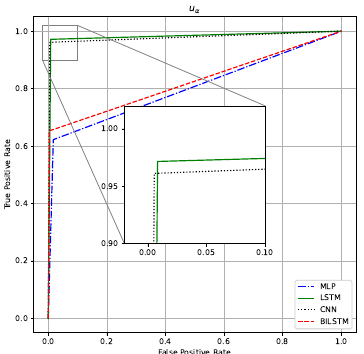
Figure 14. ROC curve for u α